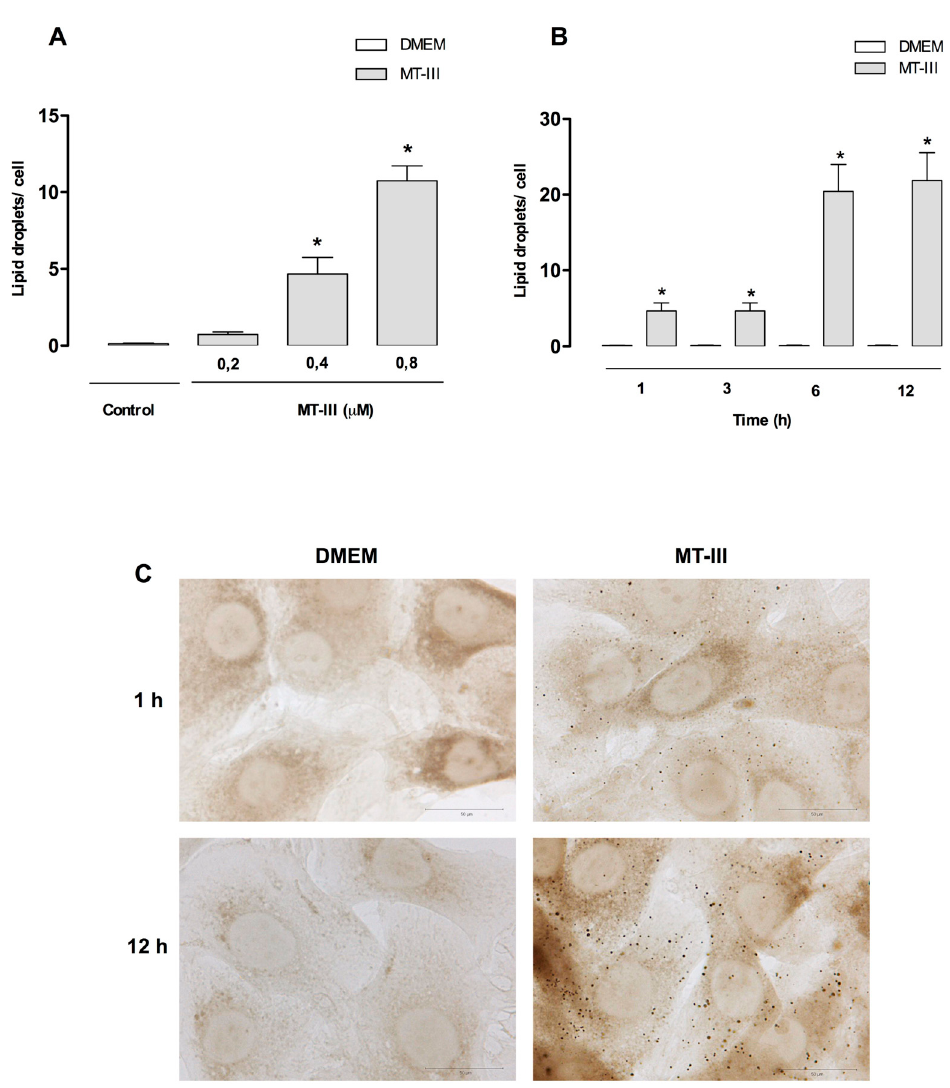
Figure 1. MT-III induces LD formation in VSMCs. ( A ) Effect of MT-III on LD formation in VSMCs stimulated with selected concentrations of MT-III or with DMEM (control) for 1 h. ( B ) Time-course of MT-III-induced LD formation. VSMCs (8 × 10 3 cells/coverslip) were incubated with MT-III (0.4 µM) or DMEM (control) for 1, 3, 6, or 12 h. LDs were quantified using light microscopy after OsO